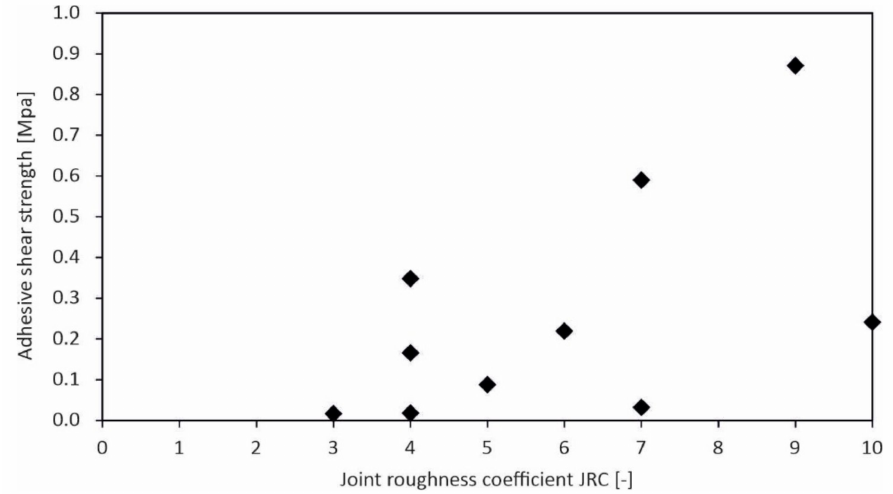
Figure 15. Comparison of the adhesive shear strength with the stone surface roughness